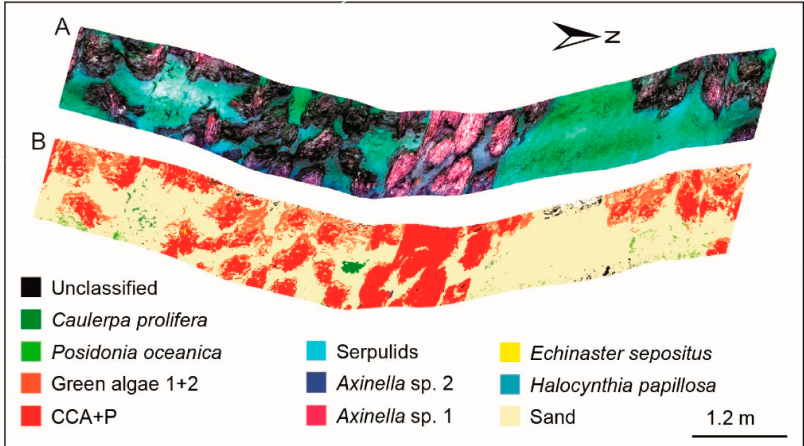
Figure 5. Cold-water coral habitat mapping: ( A ) RGB image of the coralligenous site, and ( B ) spectral angle mapper (SAM) classification image based on data in ( A ). Reprinted from Foglini et al. [86].